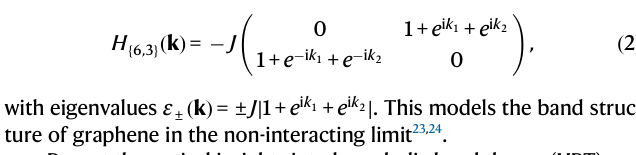
complex-phase element imprints tunable Bloch phases along edges connecting neighboring sites. The circuit element is directed, with e i ϕ imprinted in one direc- tion,and e − i ϕ intheother.ThisleadstoHermitianmatrices H ( k ).Unit-cellcircuitsfor the{8,4}( e )and{8,3}( f )hyperboliclattices.TheBravaislatticeisthe{8,8}latticein either case, with 4 and 16 sites in the unit cell, respectively. In these lattices, Bloch waves carry a four-dimensional momentum k =( k 1 , k 2 , k 3 , k 4